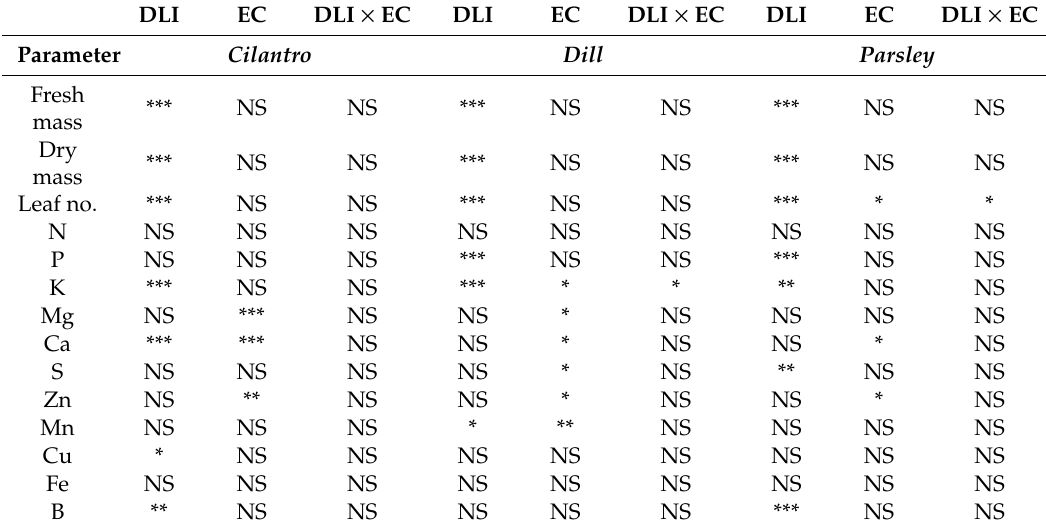
Table 3. Analysis of variance for fresh and dry mass, node number, and nutrient concentrations for cilantro ( Coriandrum sativum ‘Santo’), dill ( Anethum graveolens ‘Fernleaf’), and parsley ( Petroselinum crispum ‘Giant of Italy’) 4 weeks after transplanting into nutrient-film technique hydroponic systems in a greenhouse under a low (~7 mol · m − 2 · d − 1 ) or high (~18 mol · m − 2 · d − 1 ) daily light integral (DLI) with a